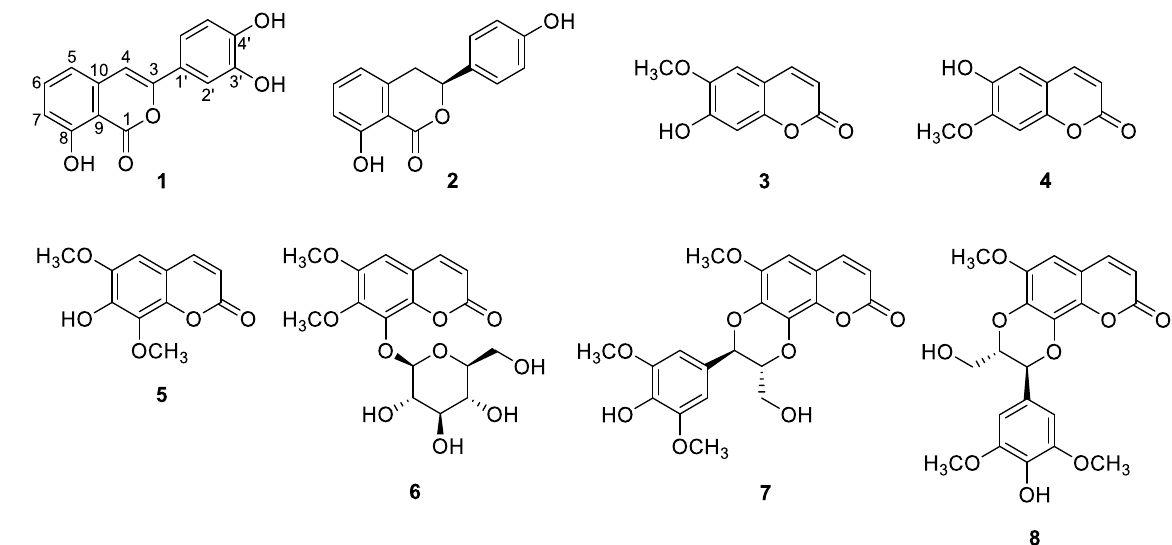
Figure 1. Chemical structures of isolated compounds from Acer mono Maxim. ( 1 − 8 ).